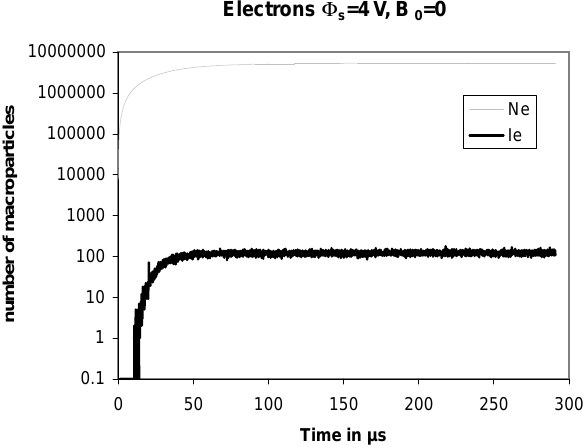
Fig. 3. Temporal evolution of collected current (thick curve, I e ) and electron density (thin curve, N e ) in macroparticle unit, for 8 s = 4V, T e = 1eV and without magnetic field. The electron current is obtained by counting the number of macroparticles impacting the spacecraft body surface during a time step.